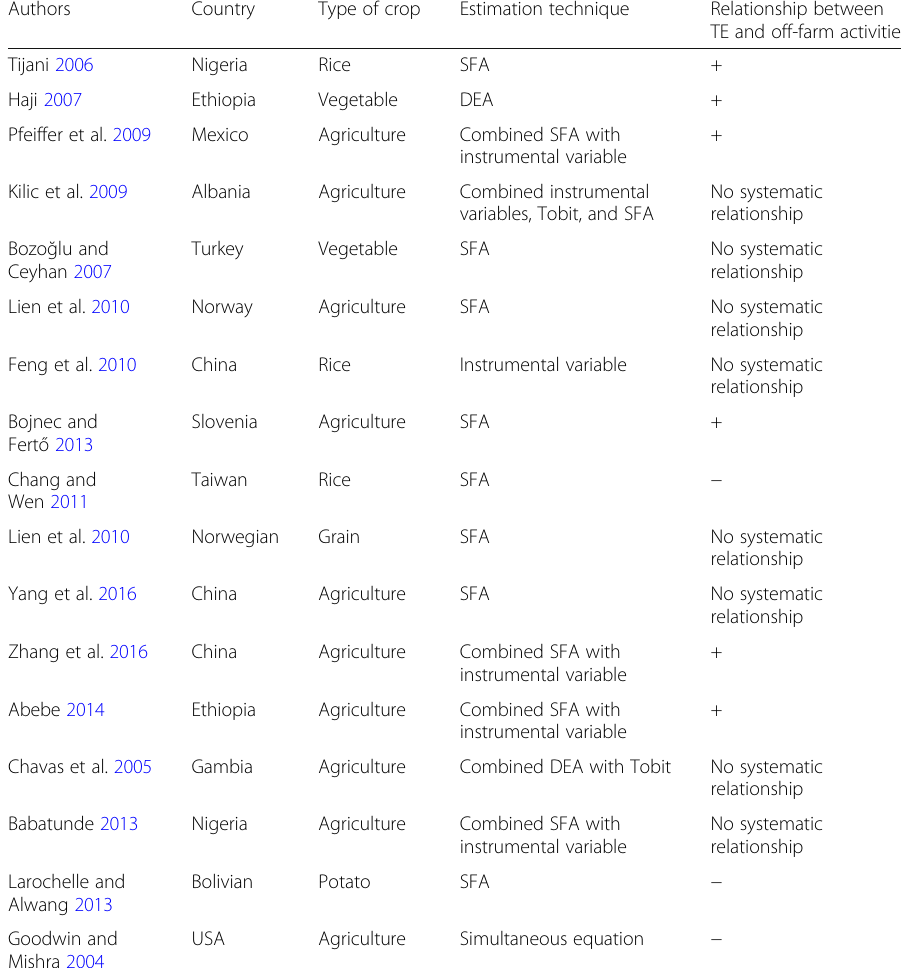
Table 1 Summary of the studies which examined the relationship between off-farm income and technical